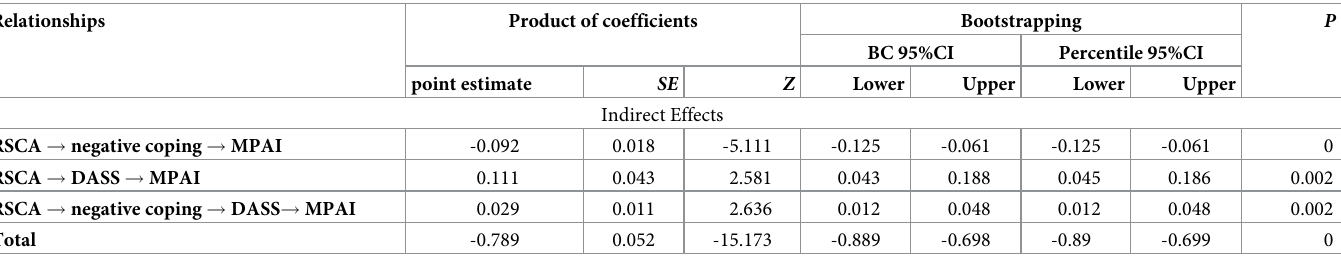
Table 5. Bootstrap truncated regression results.